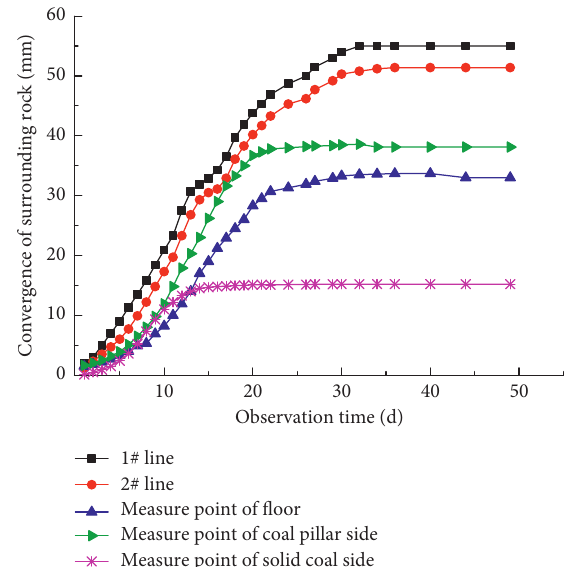
Figure 13: Field mine pressure observation